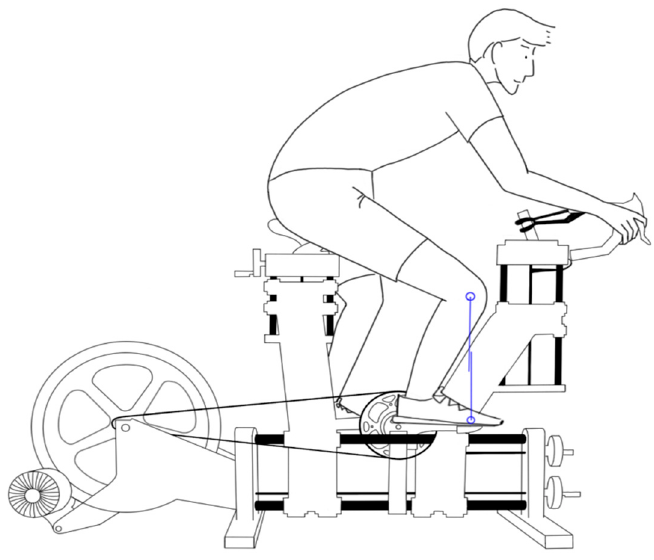
Figure 1. The dynamic fitting bike and system was used to adjust the cyclist’s pedaling position. The knee-forward-of-foot (KFOF) distance was calculated by the vertical lines of the knee and the foot markers (blue lines) during dynamic cycling.